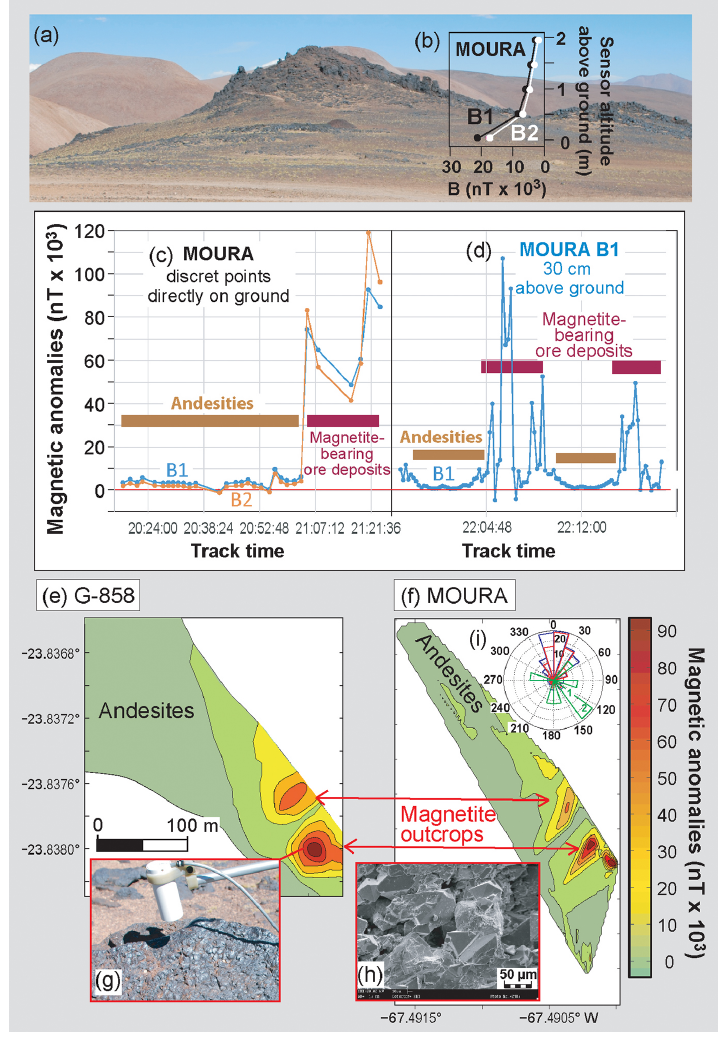
Figure 2. Magnetic and geological features of El Laco Sur. (a) A 150m wide outcrop of magnetite-bearing ores. (b) the MOURA vector measurements at different distance from the ground. (c) the MOURA track with discrete measuring points across the transition between andesite and magnetite-bearing ore outcrops. (d) The MOURA track with the sensor B1 in a continuous mode across different patches of andesites and outcrops of magnetite-bearing ores. (e) Interpolated map calculated from survey tracks with G-858 magnetometer. (f) Interpo- lated map based on the MOURA mapping. (g) G-858 sensor head on a magnetite-bearing rock surface. (h) Secondary electron image of the magnetite-bearing rock surface. (i) Comparison of declination frequencies calculated from the MOURA vector sensors (B1 in blue and B2 in red) along a 950m long track line including 125 data points. Green orientations indicate palaeo-declinations determined by Alva-Valdivia et al.